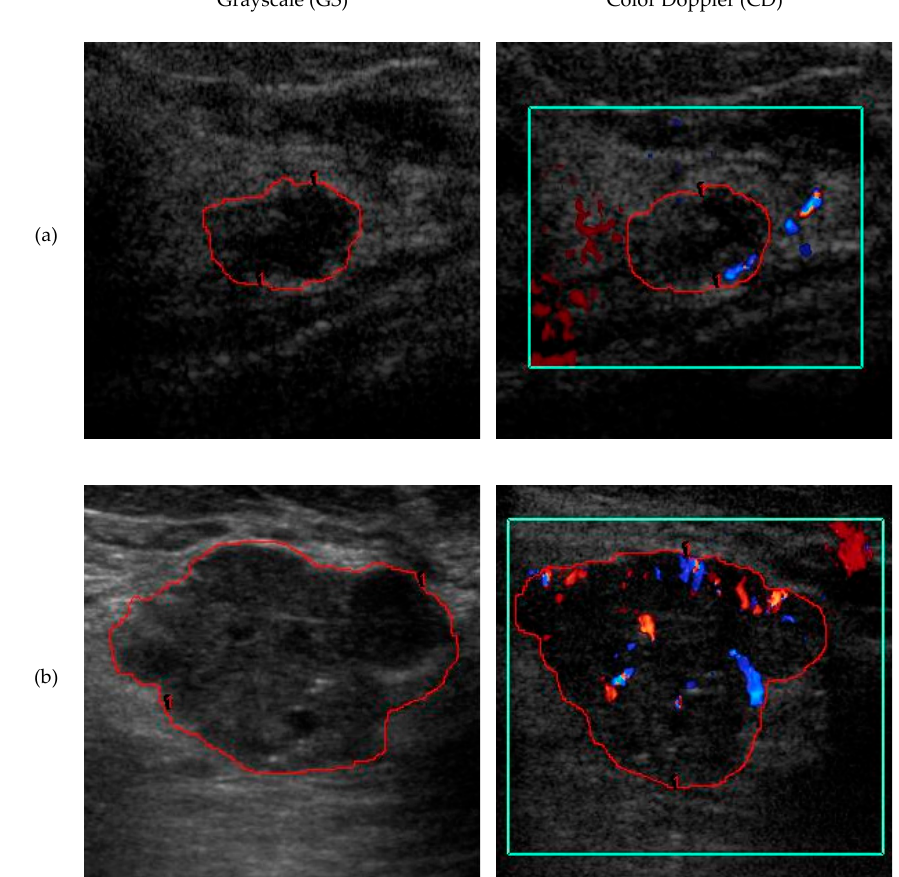
Figure 1. GS and CD ultrasound images of two breast masses. Each row contains one mass. The red outlines indicate the manually drawn ROI. The ROI is slightly different between CD and GS because the scanning plane changed. The green box is the Doppler box defined by the sonographer for displaying CD signal. ( a ) Benign mass, BI-RADS US Category 4, 47-year-old woman. ( b ) Malignant mass, BI-RADS US Category 4, 38-year-old woman. In both cases, the predictive model trained without CD features diagnosed the mass incorrectly, but with CD features the model’s diagnosis was correct. (GS = grayscale; CD = color Doppler; BI-RADS US = Breast Imaging Reporting and Data System for